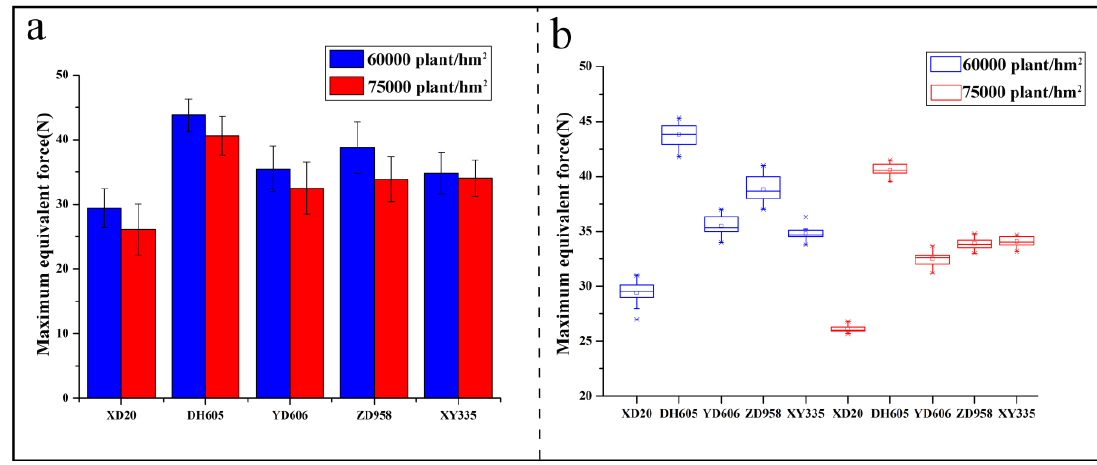
Figure 6. Comparison of the equivalent forces for the five corn varieties with two planting densities. ( a ) The maximum equivalent force measured by the measurement system for each variety of corn with different plant densities; ( b ) the box-plot for each variety of corn with different plant densities.